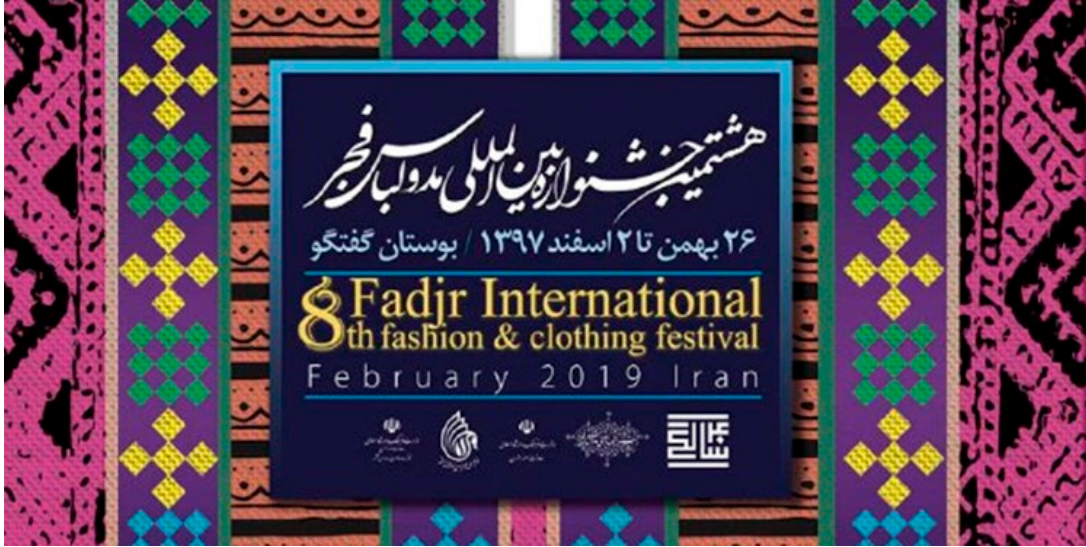
Figure 14. 8th Fajir International Fashion and Clothing Festival (2019). The outside border design of this poster contains a traditional hand embroidery of Mokran in the province of Iranian Baluchistan on the eastern border of Iran. Photo credit: Iran Press Mahdieh Baharmast Source: http://iranpress.com/iran-i132465.